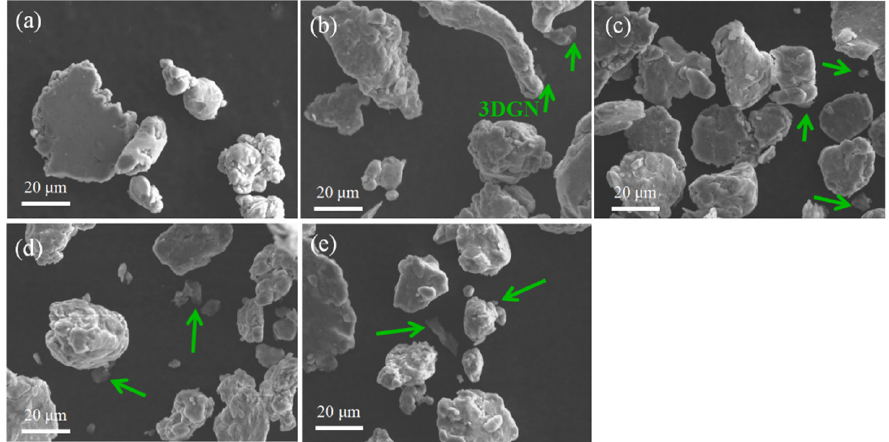
Figure 4. SEM images of ( a ) ball ‐ milled pure Al powder, ( b ) ball ‐ milled 0.075% ‐ 3DGN/Al composite powders, ( c ) ball ‐ milled 0.150% ‐ 3DGN/Al composite powders, ( d ) ball ‐ milled 0.225% ‐ 3DGN/Al composite powders, and ( e ) ball ‐ milled 0.300% ‐ 3DGN/Al composite powders. The green arrows indicate the distribution of 3DGN.